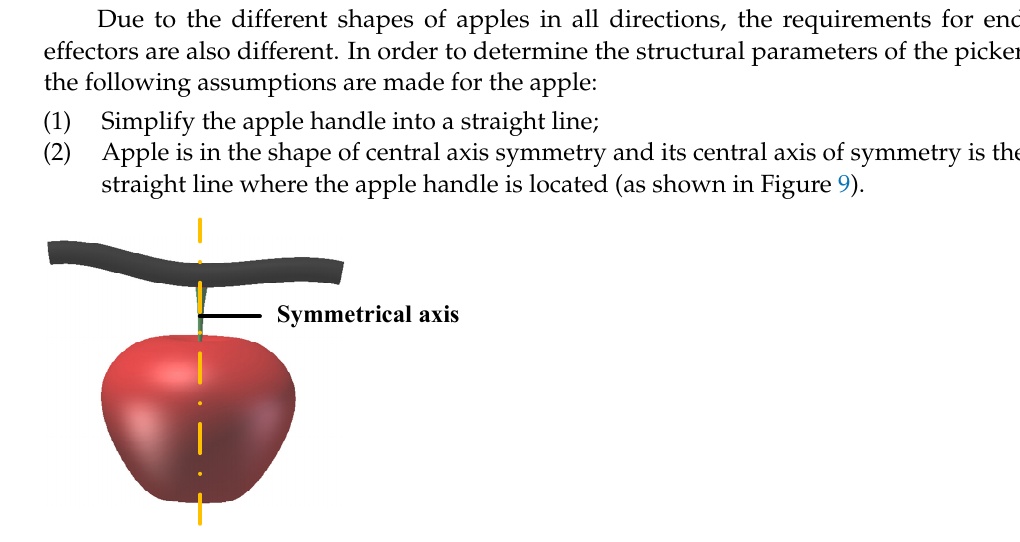
Figure 8. Classification of apple growth posture: A represents calss A; B represents class B; C repre- sents class C.